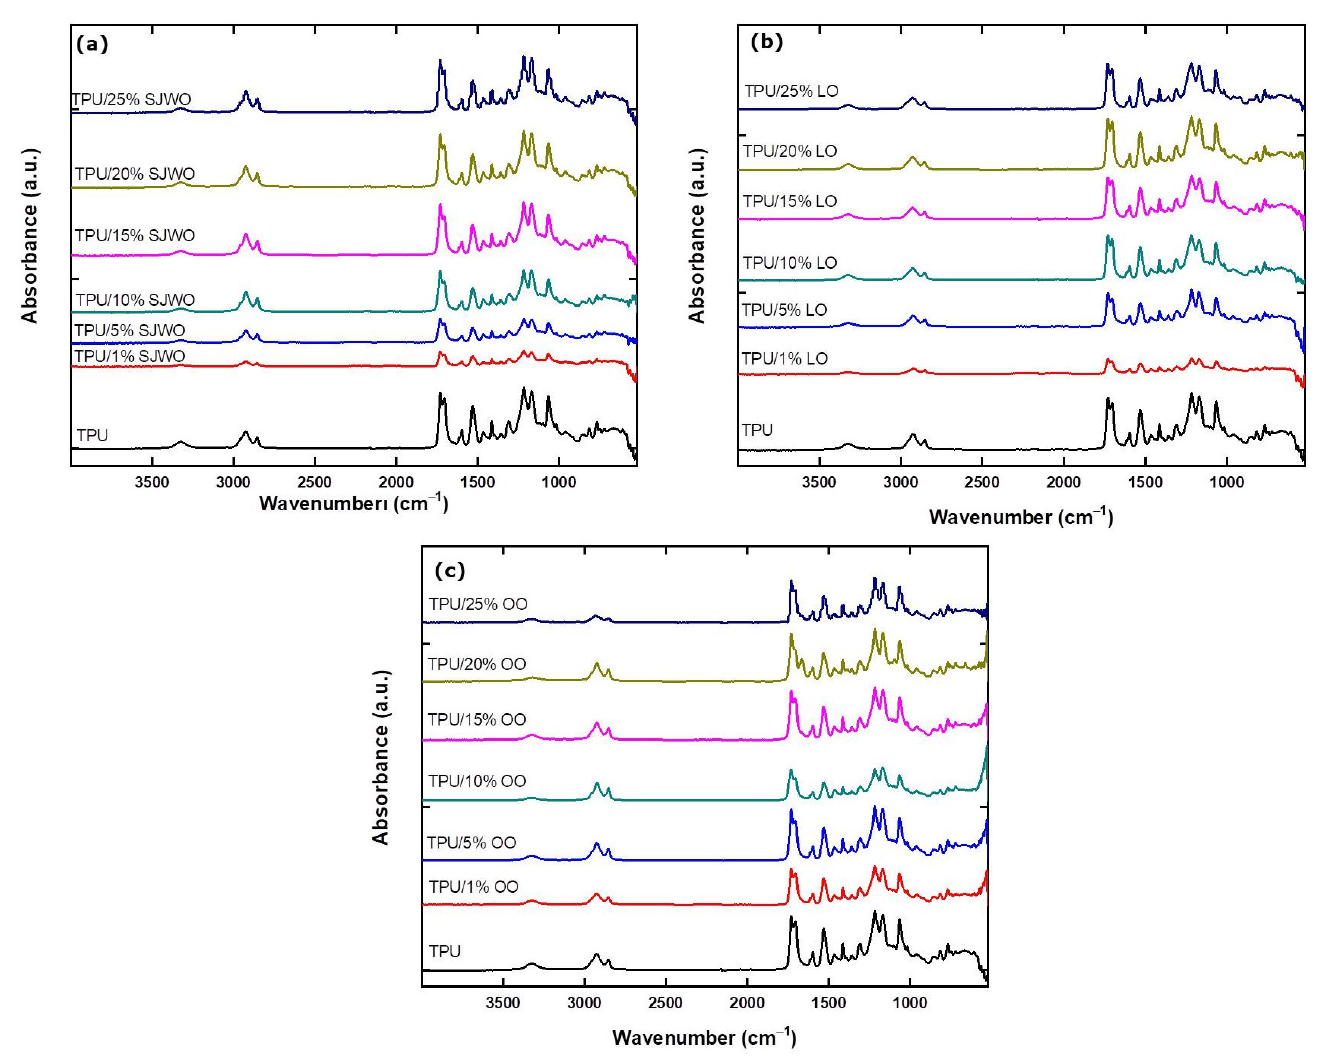
Figure 7. FTIR spectra of ( a ) TPU/SJWO fibers, ( b ) TPU/LO fibers, and ( c ) TPU/OO